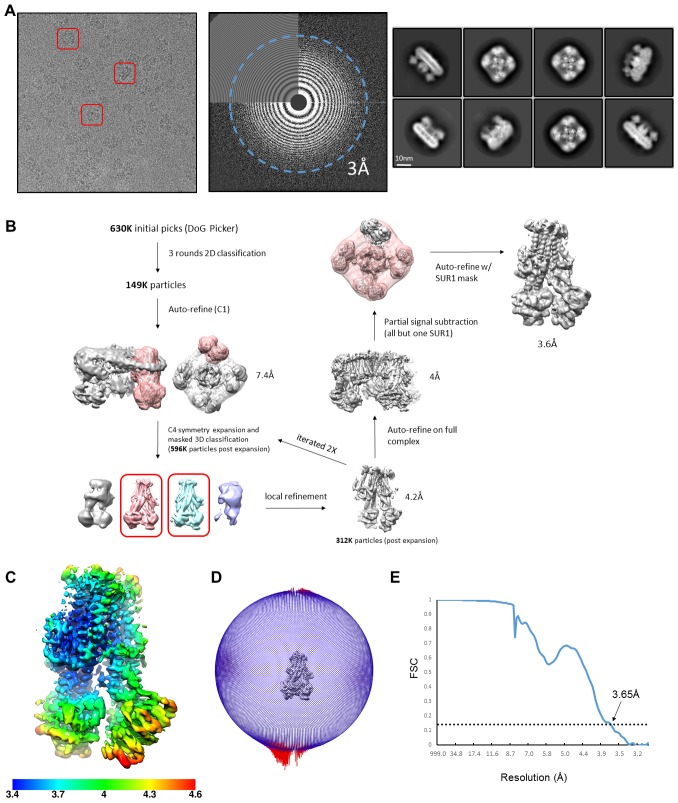
Data collection and image processing workflow for the RPG/ATP state.(A) Left: Representative micrograph after alignment with Motioncor2. A few KATP channel complexes of various orientations are outlined by the red box. Middle: Power spectrum calculated with Ctffind4, with resolution reaching 3.0 Å. Right: Representative 2D classes. (B) Overview of data processing workflow. Particle picking was performed automatically with DoGPicker and manual inspection. All other image processing steps were performed in RELION-3. (C) Local resolution plot of focal refined SUR1 map. (D) Angular distribution plot. (E) Fourier shell correlation (FSC) of two independent half maps of focal refined SUR1.